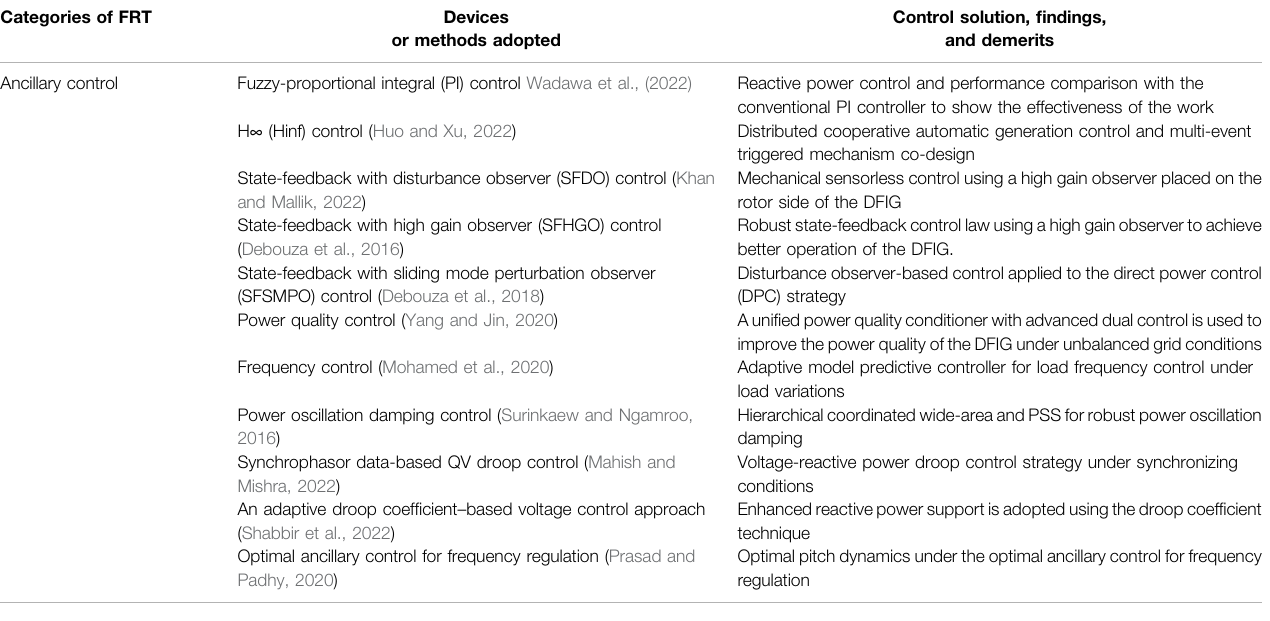
TABLE 1 | ( Continued ) Summary of various DFIG VSC-based strategies under normal and abnormal grid conditions.